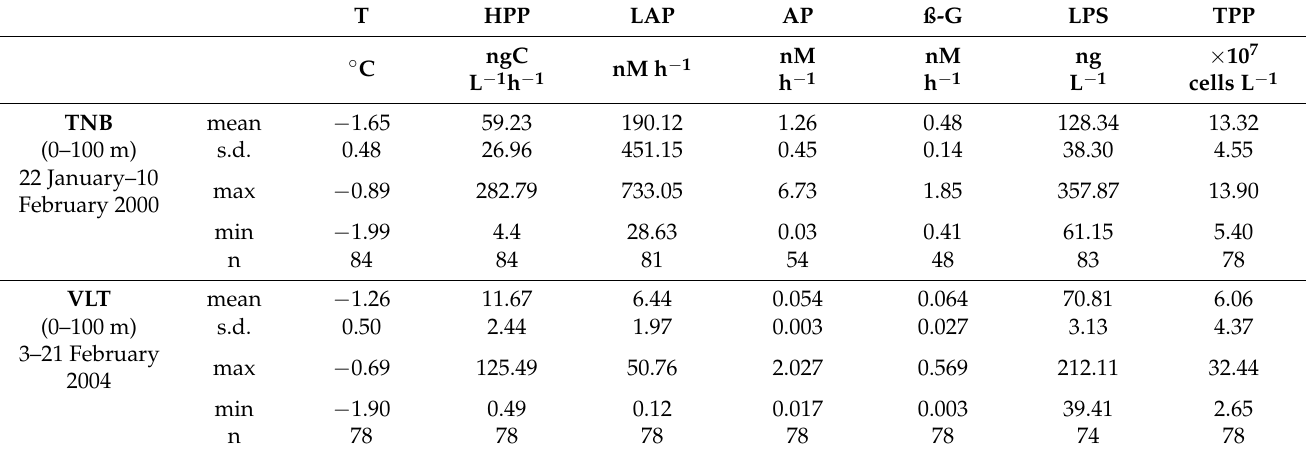
Table 1. Microbiological parameters observed in Terra Nova Bay (TNB) and Victoria Land Transect (VLT) surveys, together with temperature values. T (temperature), HPP (heterotrophic prokaryotic production), LAP (leucine aminopeptidase), AP (alkaline phosphatase), ß-G (ß-glucosidase), LPS (lipopolysaccharide), and TPP (total